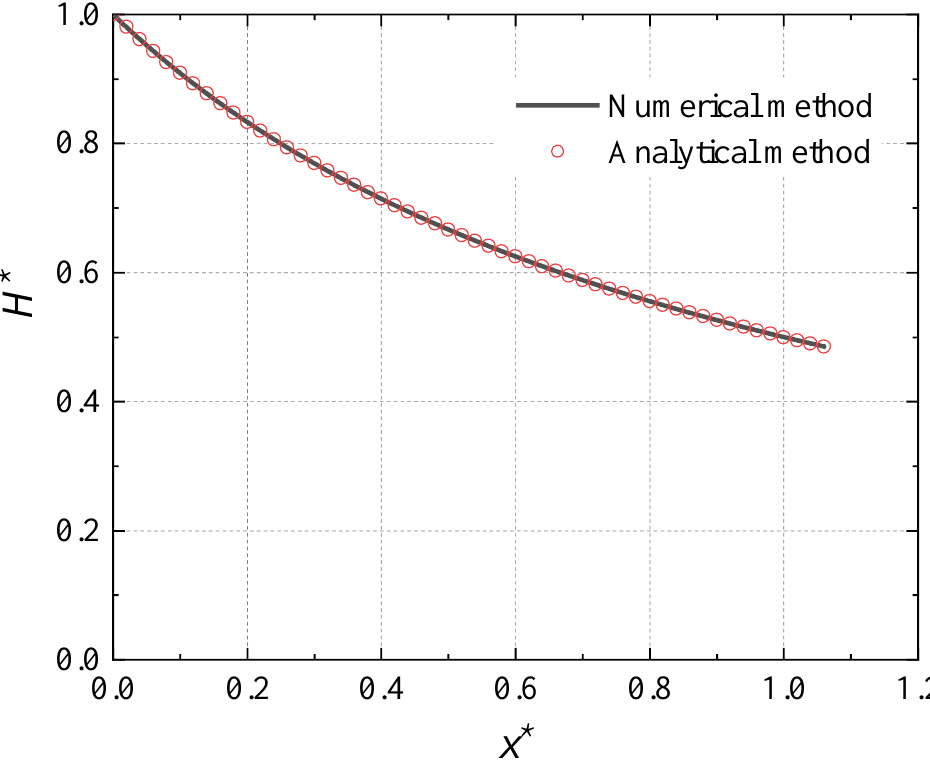
Figure 2. Wave height damping over constant water depth.